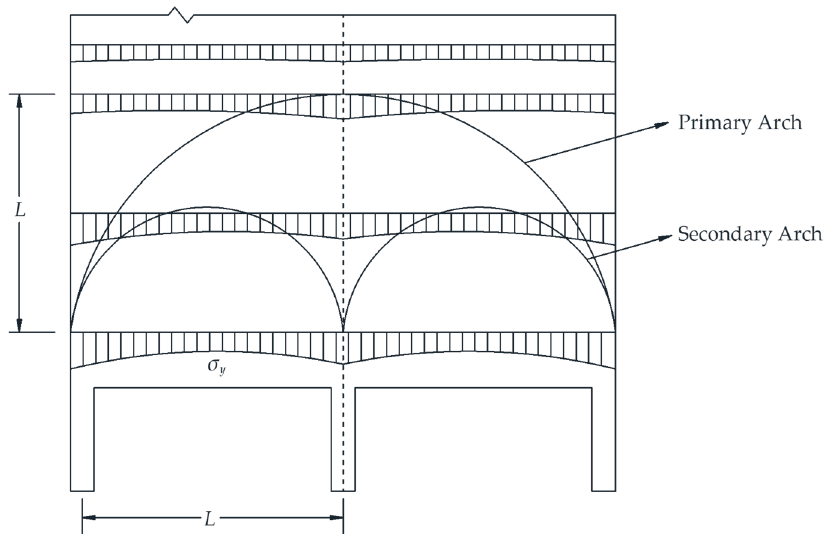
Figure 3. Distribution of vertical stress in transfer girder-shear wall system (redrawn from Kuang and Zhang [11]).